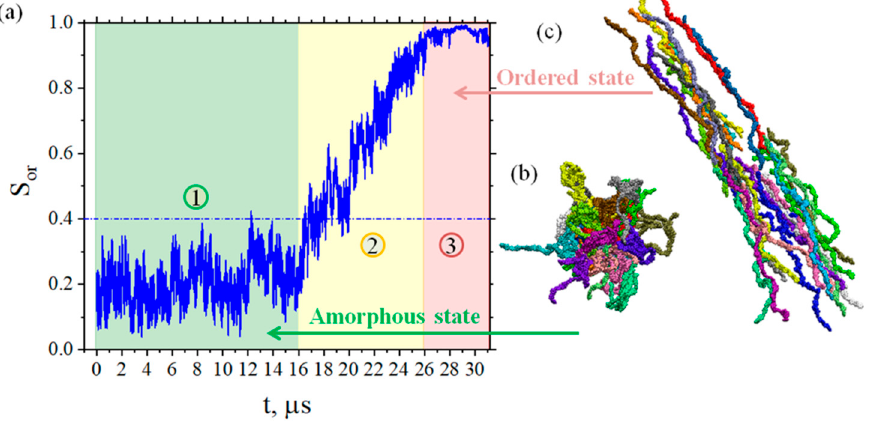
Figure 2. ( a ) Time dependence of the order parameter S or for the end-to-end vector of BPDA-P3 chains at 600 K. Area 1 denotes the amorphous state of the polymer (green color), area 2 denotes the transitional state (yellow color), and area 3 denotes the ordered state (red color). ( b ) Snapshots of a typical instantaneous configuration of the system in an amorphous state (after 5 ns of simulations). ( c ) Snapshots of a typical instantaneous configuration of the system in an ordered state (after 31 µ s of simulations). Each chain has its own color.